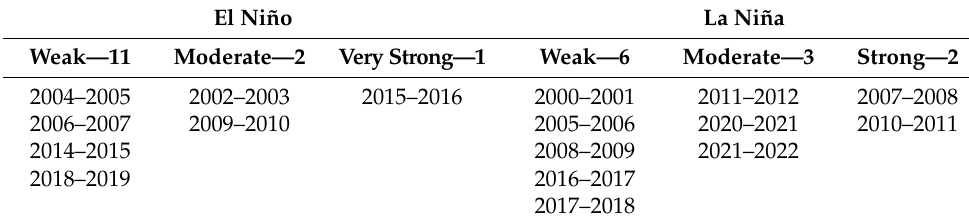
Table 1. El Niño and La Niña years and